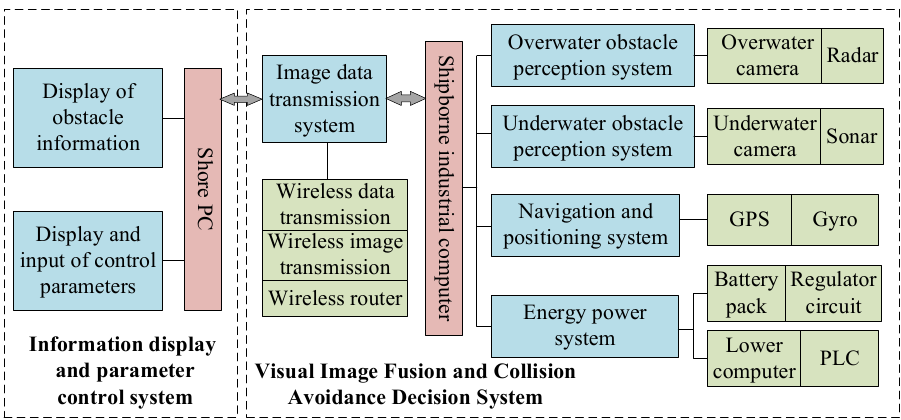
Figure 1. The overall hardware framework of the visual image fusion system.